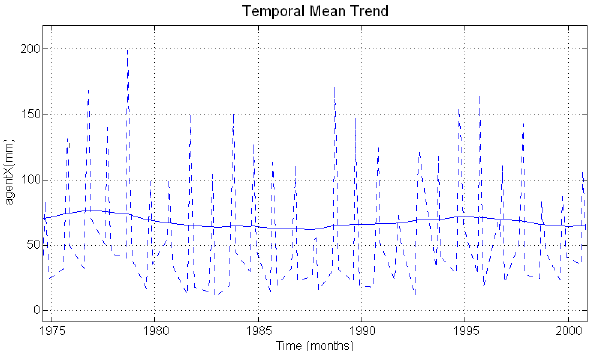
Fig. 2. The temporal mean trend aggregated over the regions.